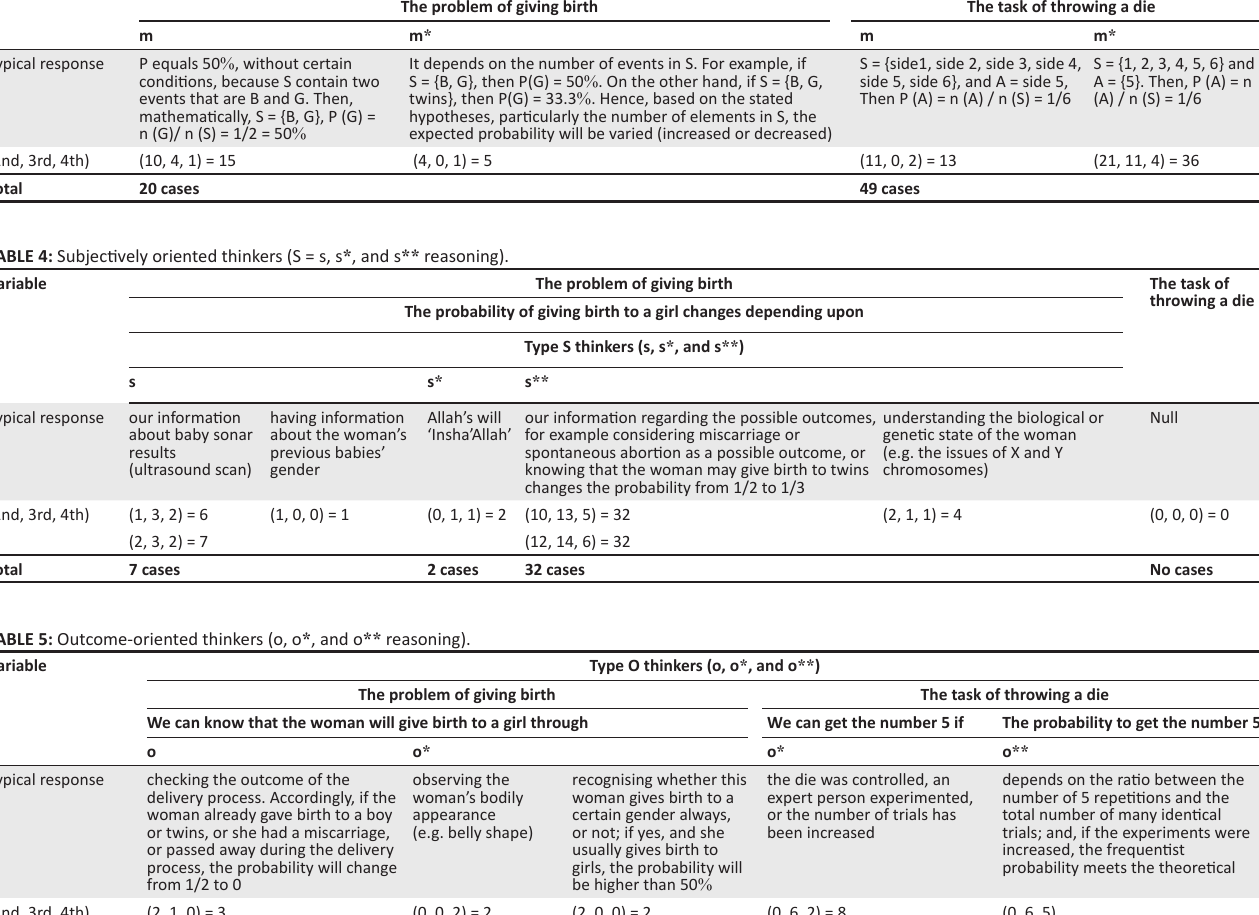
TABLE 3: Mathematically oriented thinkers (m and m * reasoning) 2 . Variable